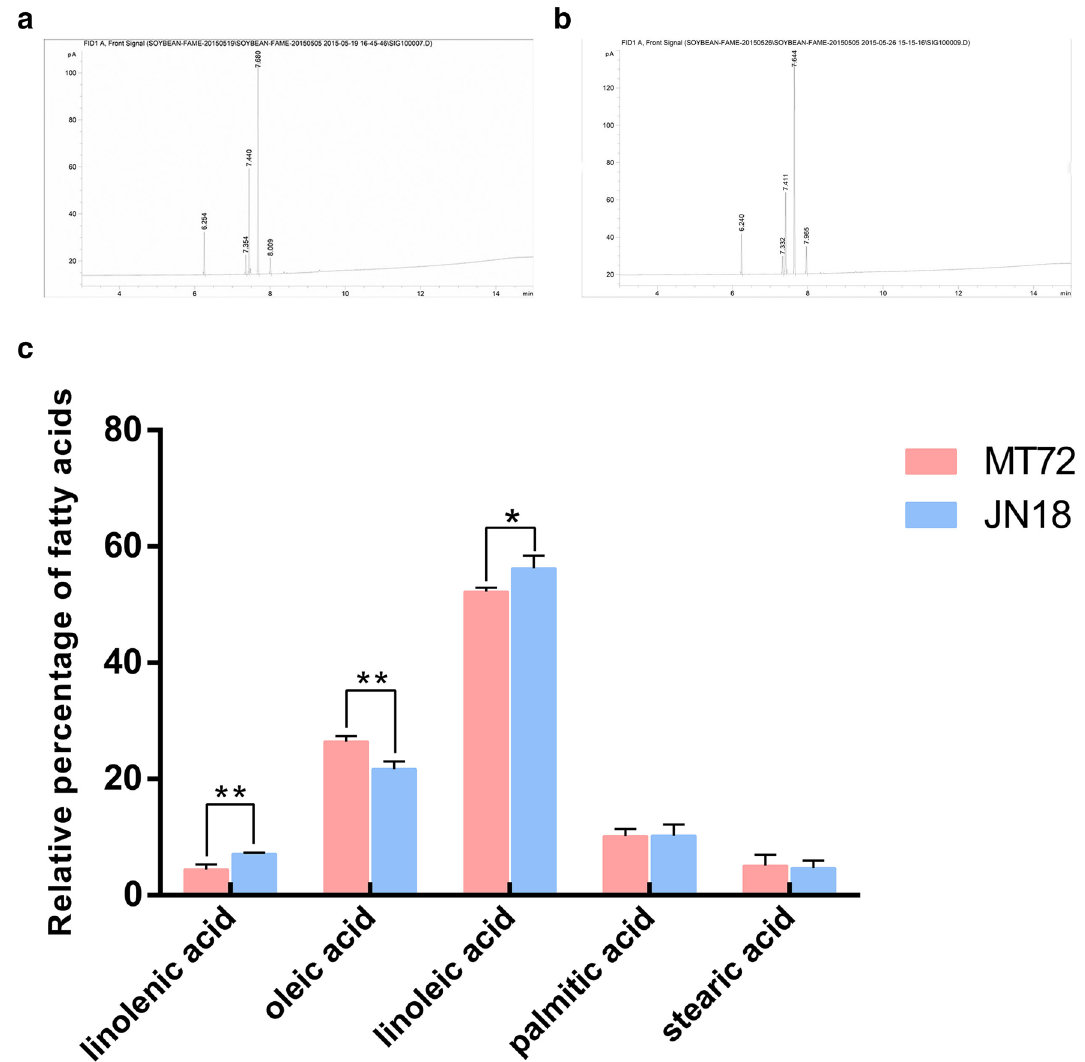
Figure 12. Quality analysis of main fatty acid components of ‘MT72 ′ and ‘JN18 ′ . ( a ) Gas chromatogram of mutant ‘MT72 ′ . ( b ) Gas chromatogram of mutant ‘JN18 ′ . (The peak times are palmitic acid, stearic acid, oleic acid, linoleic acid and linolenic acid from left to right). ( c ) Bar diagram of ‘MT72 ′ and ‘JN18 ′ different fatty acid content. *indicates a statistical difference at p < 0.05, ** indicates a statistical difference at p <